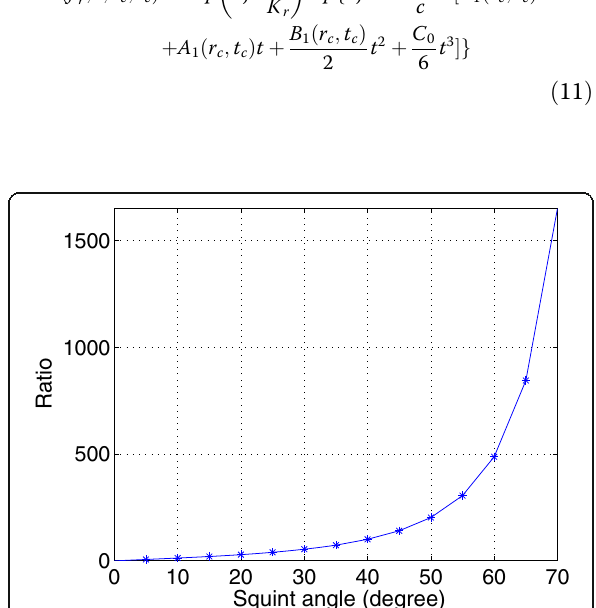
Fig. 3 WCR ( θ R ) with varying squint